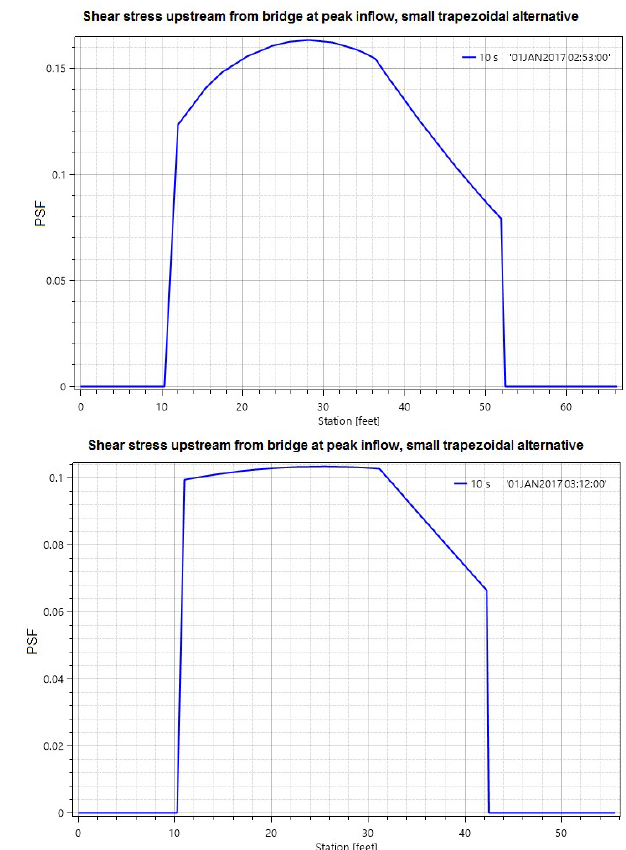
Figure 10. Comparison between Shear Stresses in the Channel Ob- tained with the Large Trapezoidal and Small Trapezoidal Cross Sec- tion Alternatives.